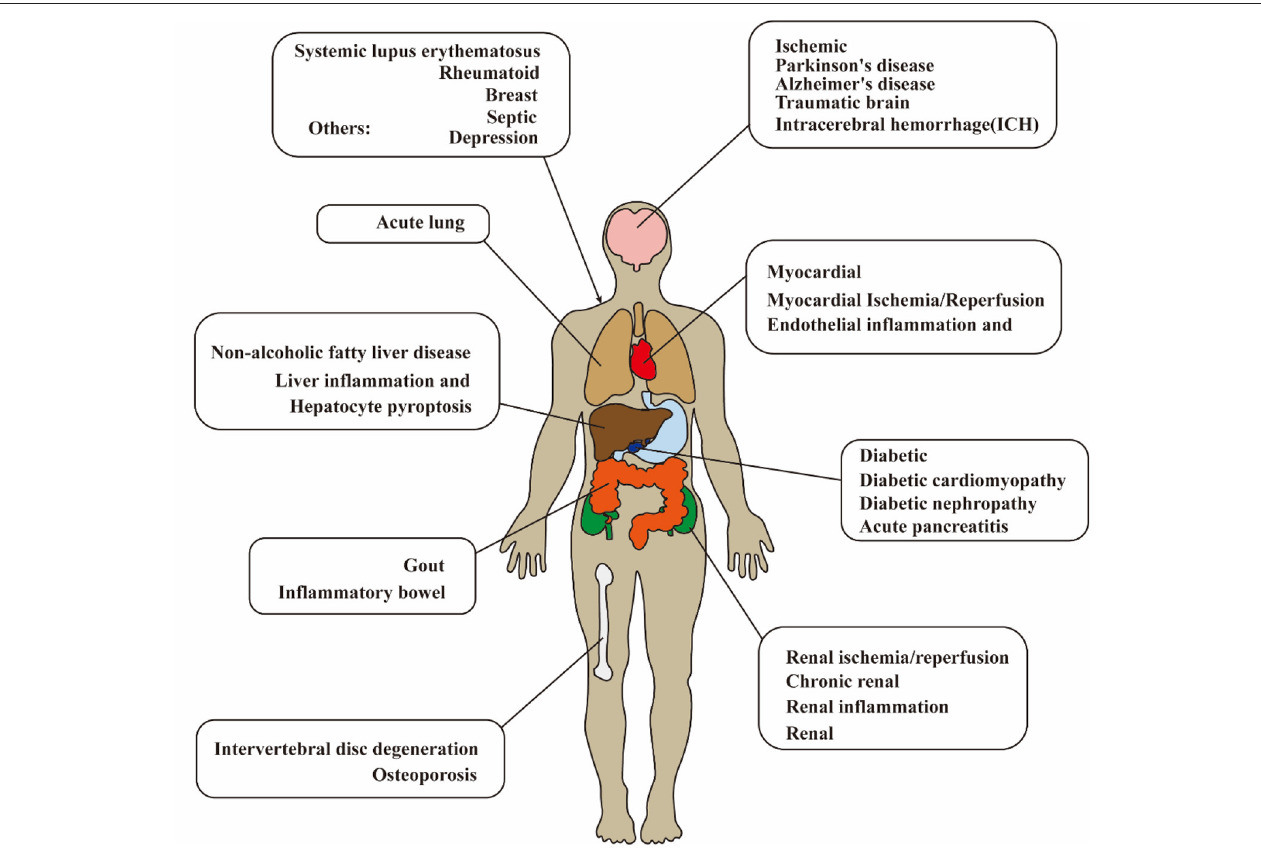
FIGURE 1 | Diagram of NLRP3 inflammasome-related disease in human. The activation of NLRP3 inflammasome is extensively involved with the onset and progression of various diseases. NLRP3, pyrin domain-containing protein 3.